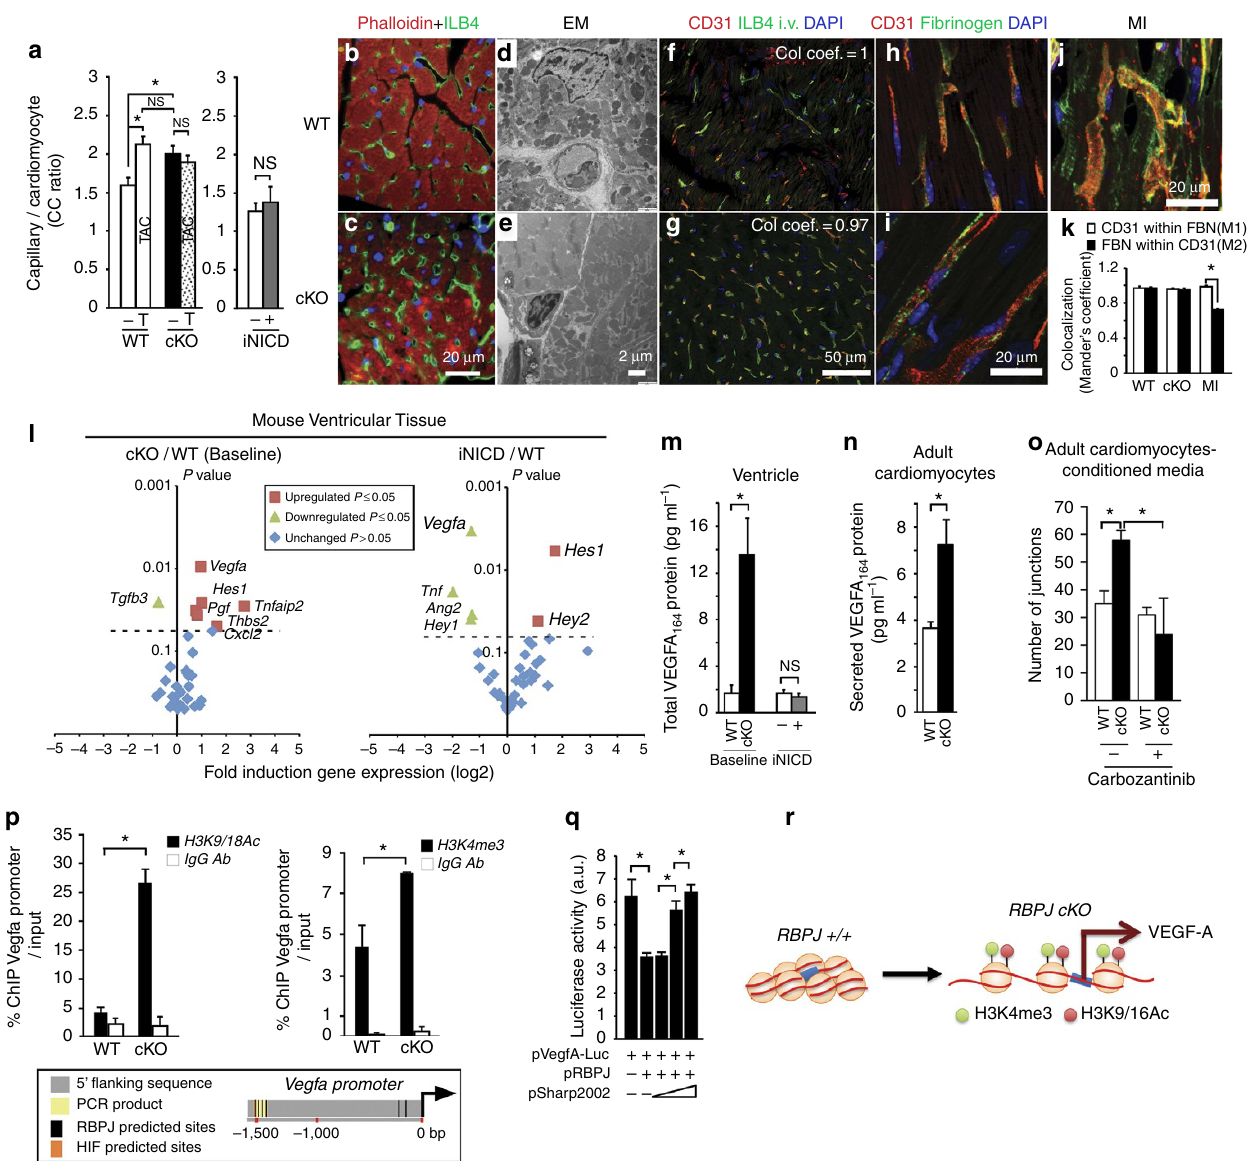
Figure 2 | Cardiomyocyte-specific knockout of RBPJ increases myocardial angiogenesis. ( a – c ) Microvessel density quantification ( a ) on histological sections ( b , c ). Experimental genotypes are cKO ( Myl 2 Cre/ þ , Rbpj flox/flox ) and WT ( Myl 2 þ / þ , Rbpj flox/flox ) sham ( (cid:2) ) or TAC (T), and iNICD ( Myh6 rtTA , tetO-NICD ) with ( þ ) or without ( (cid:2) ) doxycycline (DOX). n ¼ 4, mice for all conditions except WT/ þ TAC were n ¼ 3. Scale bar, 20 m m. ( d , e ) Electron microscopy of WT ( d ) and cKO ( e ) capillaries at 48 months. Scale bar, 2 m m ( f , g ) Perfusion analysis by ILB4 and CD31 co-localization after FITC-ILB4 injection. n ¼ 3WT, and 5cKO mice. Scale bar, 50 m m. ( h – k ) Co-localization between fibrinogen (green) and CD31 (red) in WT ( h ), cKO ( i ) and control WT-infarcted heart (MI) reflecting capillary integrity. ( k ) n ¼ 3. Scale bar, 20 m m. ( l ) Gene expression analysis of 29 secreted angiogenic factors and 3 Notch target genes in ventricles from cKO, WTand doxycycline-induced iNICD mice by qRT-PCR normalized to ActB . Volcano plots portray the cKO to WT ratio or iNICD to WT ratio relative to P -value. Red and green points indicate statistically significant ( P r 0.05, n ¼ 4) induction or repression of gene expression, respectively; blue points indicate no statistically significant difference. ( m , n ) VEGFA 165 protein quantification by ELISA in WT, cKO and iNICD heart tissue ( m ) and conditioned media from WTand cKO-cultured ACM n ¼ 4 ( n ). ( o ) Conditioned media from WTand cKO ACM were applied to HMEC1 cells and network formation quantified incubation in the absence or presence of the VEGF receptor inhibitor carbozantinib (2 m M). n ¼ 3. ( p ) Histone marks in the endogenous Vegfa locus. ChIP with control IgG (white bars) and anti-H3K9/18Ac or anti-H3K4me 3 (black bars) from isolated ACM was amplified using primers spanning RBPJ and HIF consensus binding motifs (schematic) and results normalized to input DNA. n ¼ 3. ( q ) Repression of Vegfa promoter- luciferase (50 ng) activity by RBPJ (1 ng) and reversion by co-transfection with escalating doses (0.5, 1 and 10ng) of the SHARP RBPJ-binding domain (2002-3664) (ref. 18). n ¼ 3. ( r ) Loss of RBPJ leads to acquisition of active chromatin modifications and induction of Vegfa transcription. Data are mean ± SEM * P o 0.05; ns, not significant; n , biological interventricular septum (IVS) since the left ventricle (LV) free wall was injured by the MI. The extent of fibrotic scar formation was also diminished significantly, from 25 ± 4.3% of the total LV area in WT to B 8 ± 3.0% in icKO hearts (Fig. 3n). The area of